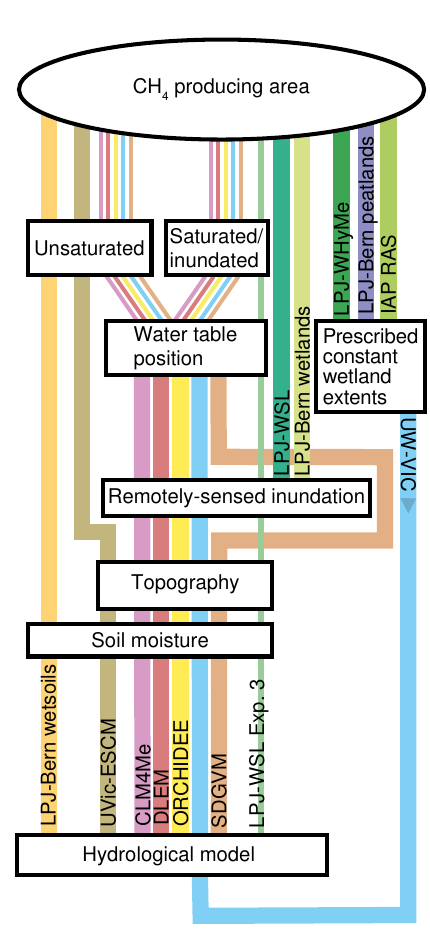
Fig. 6. Conceptual overview of how the participating models de- rive their “CH 4 producing area” (MPA). Each model (and in some cases, version) is represented by a different colour. The flow of a particular model starts with the model’s name and ends at the “CH 4 producing area”. The simplest models rely on “Prescribed constant wetland extents” to define their MPAs (LPJ-WHyMe, LPJ- Bern peatlands, IAP-RAS), whereas UW-VIC uses “Prescribed con- stant wetland extents” only as maximal boundaries. LPJ-WSL and LPJ-Bern wetlands use remotely sensed inundation directly. “Soil moisture” is exclusively simulated by a “Hydrological model” and is used to either derive “Unsaturated” MPAs directly (LPJ-Bern wetsoils) or in combination with “Topography” (UVic-ESCM). Of the remaining models that use “Topography”, all but SDGVM de- pend on “Remotely-sensed inundation” data to arrive at the “Wa- ter table position”, which CLM4Me, DLEM, ORCHIDEE, UW- VIC and SDGVM use in combination with the other factors (e.g. CLM4Me also uses runoff) to determine “Unsaturated” and “Satu- rated/inundated” MPAs. LPJ-WSL (Exp. 3) uses “Water table po- sition” to obtain only the “Saturated/inundated” MPA. The order in which processes are calculated do not always strictly follow the path used in this schematic